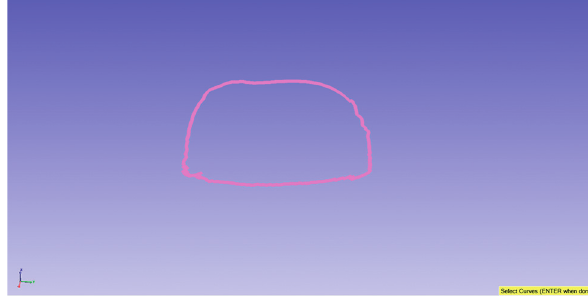
Figure 24: Foot track of the